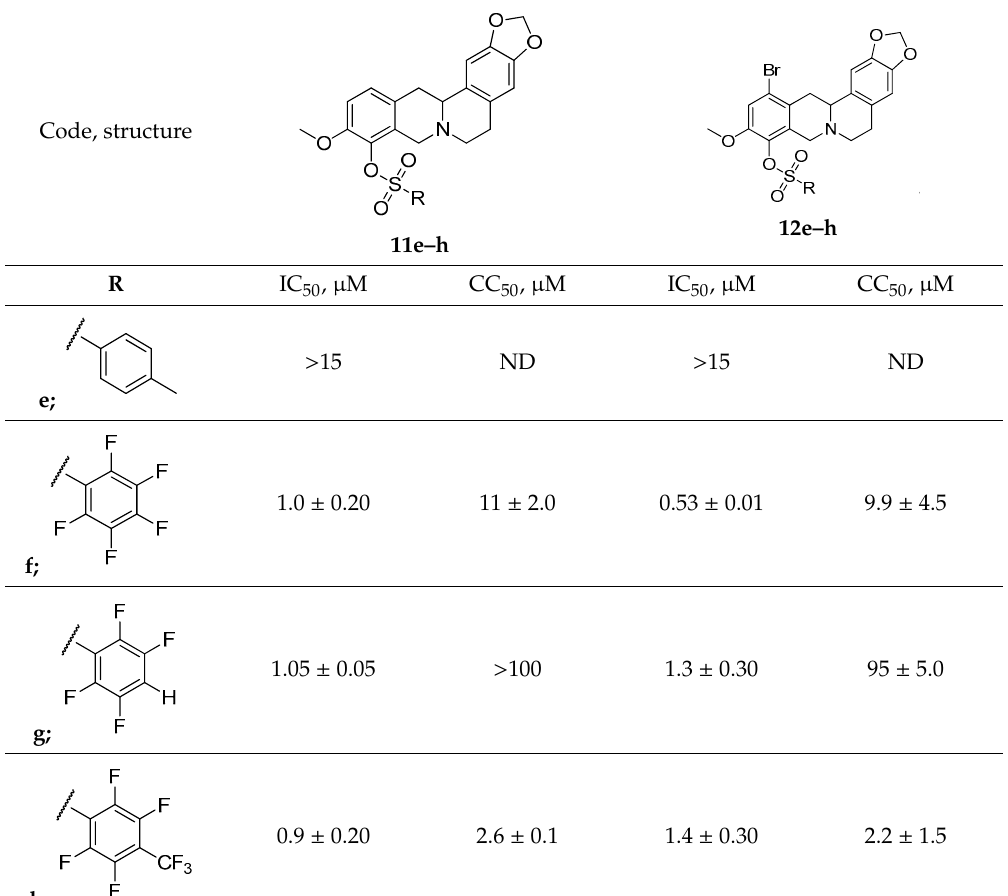
Table 2. Tdp 1 inhibiting activity (IC 50 ) of sulfonate berberine derivatives with polyfluoroaromatic substituents and their cytotoxicity (CC 50 ) in HeLa cells. Furamidine was used as a positive control (IC 50 = 1.2 ± 0.3 µM).